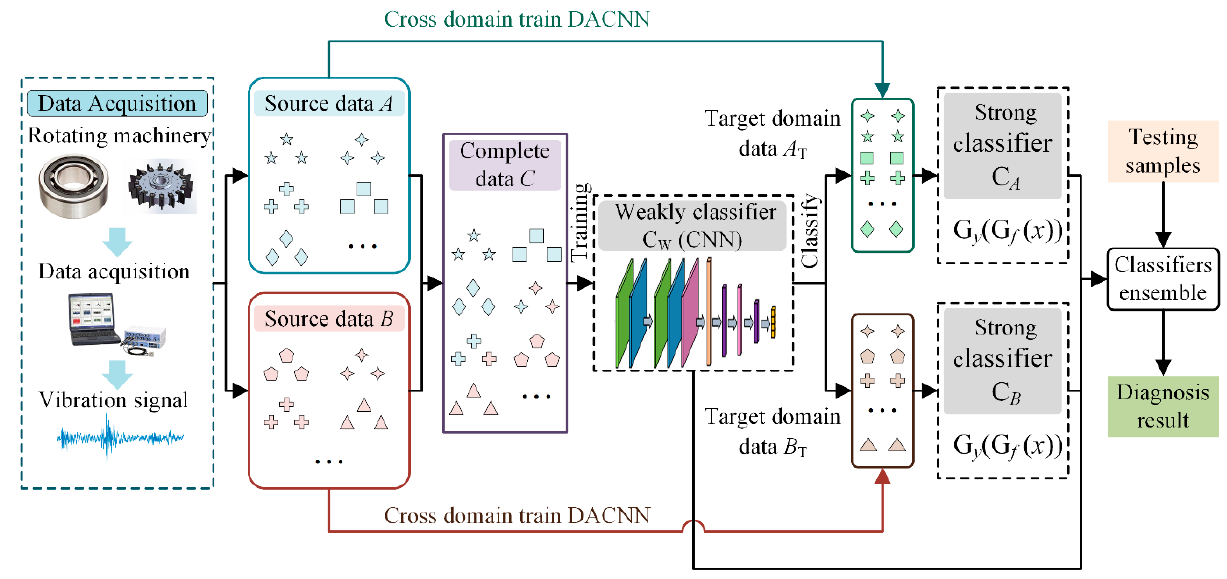
Figure 6. The overall procedures of the proposed method.